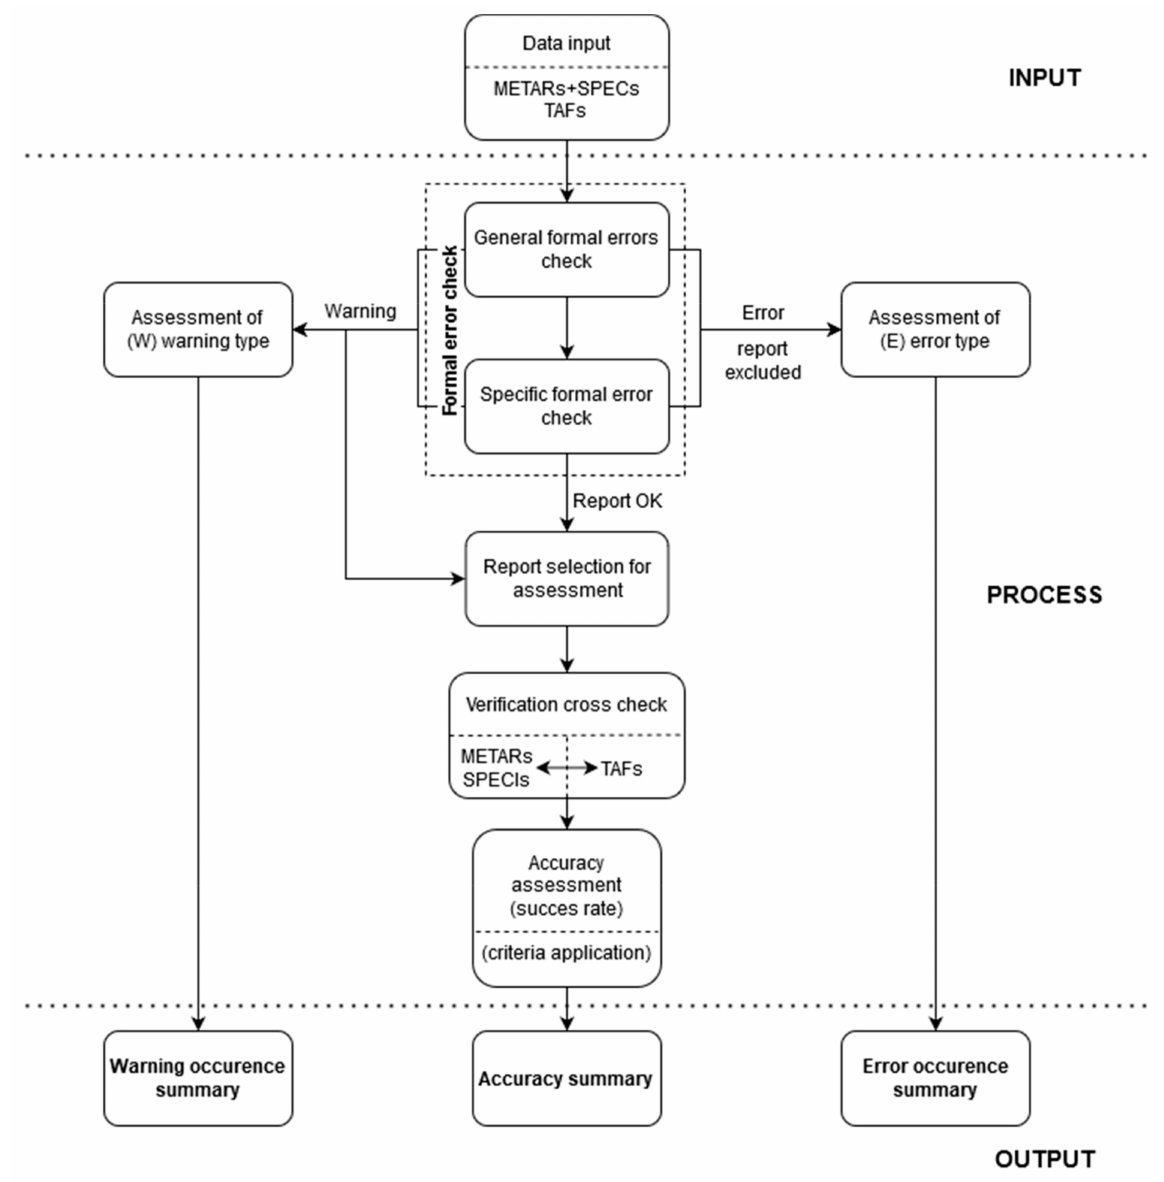
Figure 1. Scheme of the data assessment